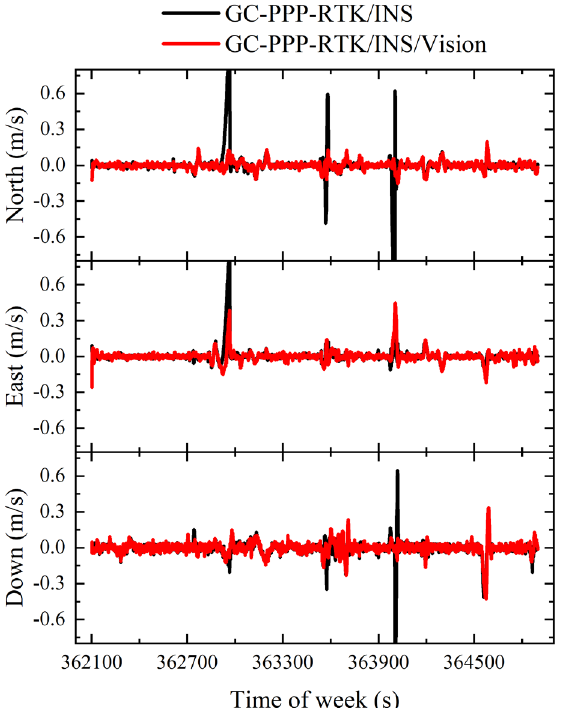
Figure 13. Velocity error series of GC-PPP-RTK/INS and GC-PPP-RTK/INS/vision for T02.